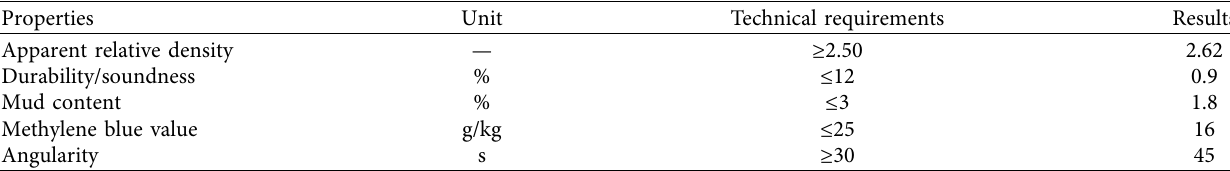
Table 2: Properties of fine aggregate.